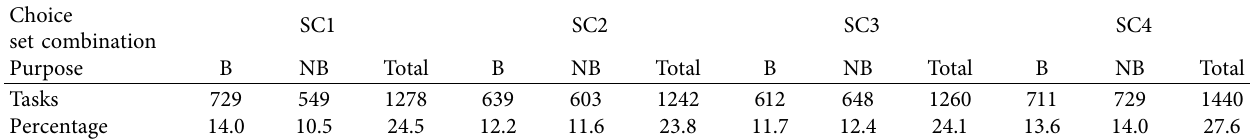
Table 4: Summary of tasks answered per choice set